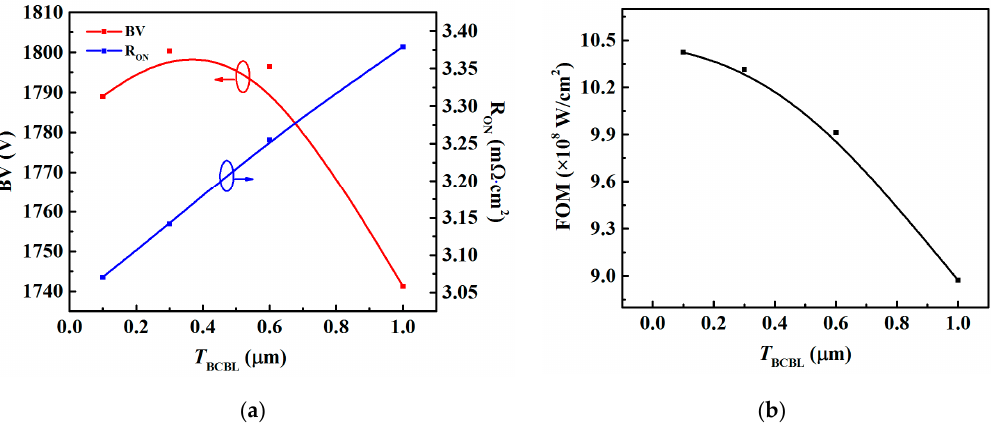
Figure 8. ( a ) BV and R ON versus T BCBL (the thickness of the BCBL) and ( b ) FOM values versus T BCBL .